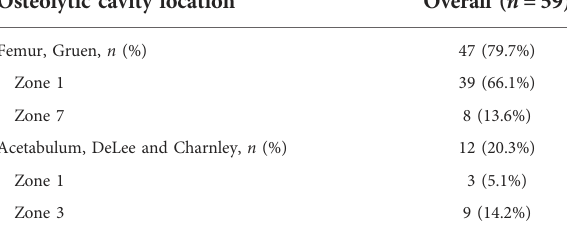
TABLE 2 Locations of osteolytic cavities according to Gruen classi fi cation (femur) and DeLee and Charnley classi fi cation (acetabulum).